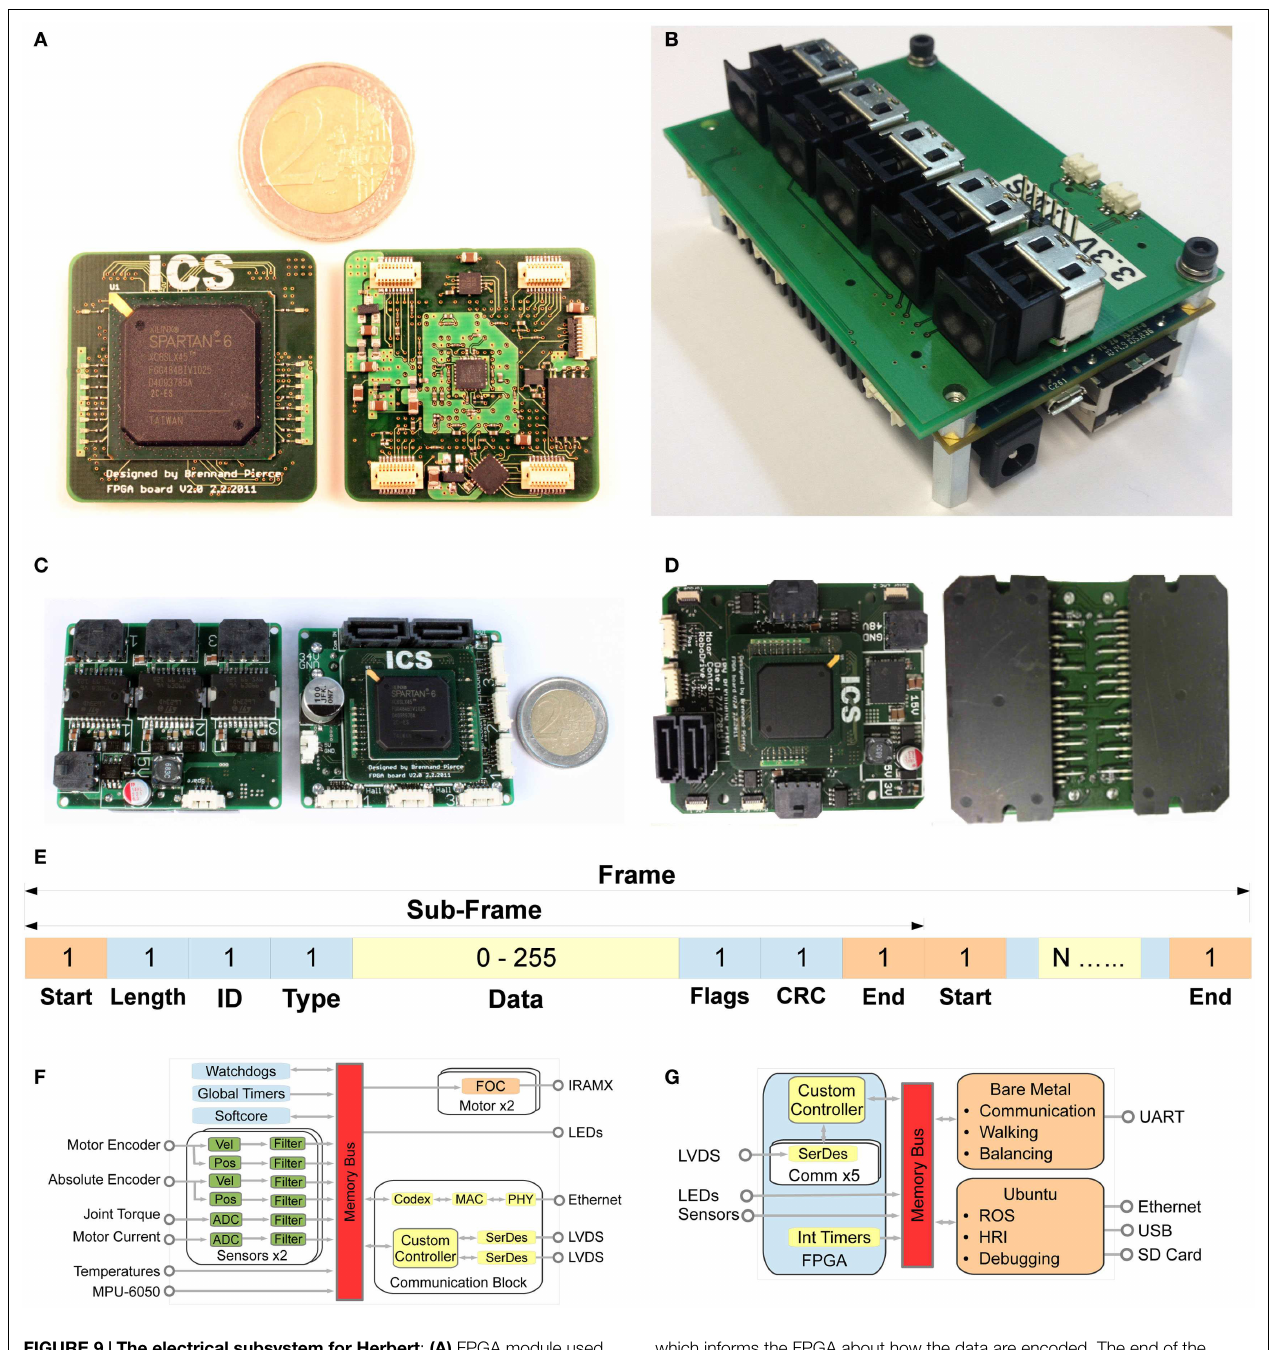
FIGURE 9 | The electrical subsystem for Herbert : (A) FPGA module used in all the sub boards. (B) The central controller with its five fiber optic connectors. (C) Low current motor controller. (D) High-voltage motor controller. (E) The data structure of the high-speed communication frame. Each sub-frame is separated with a unique start and stop word using 8/10b encoding. With a 3byte header, which consists of 1) The length of the sub-frame 2) The ID of the FPGA module that the sub-frame is for 3) The type,